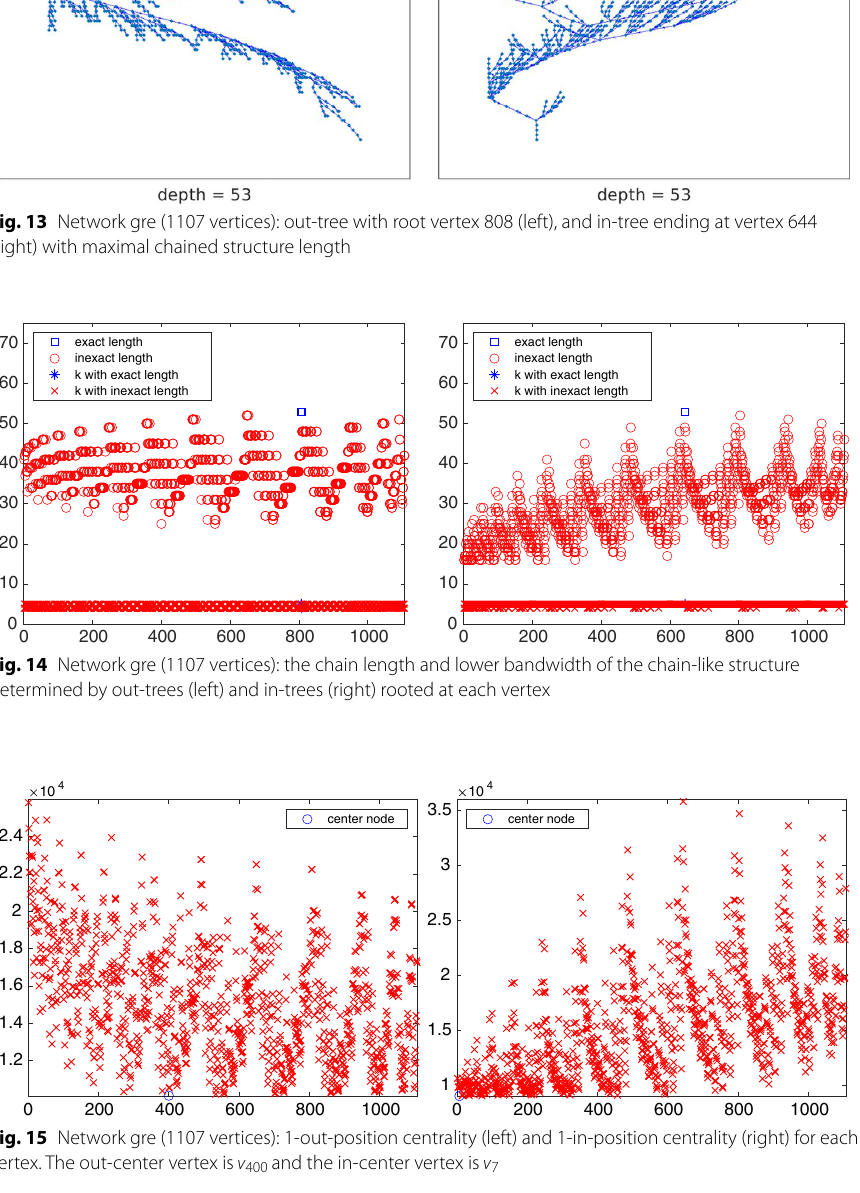
Fig. 15 Network gre (1107 vertices): 1-out-position centrality (left) and 1-in-position centrality (right) for each vertex. The out-center vertex is v 400 and the in-center vertex is v